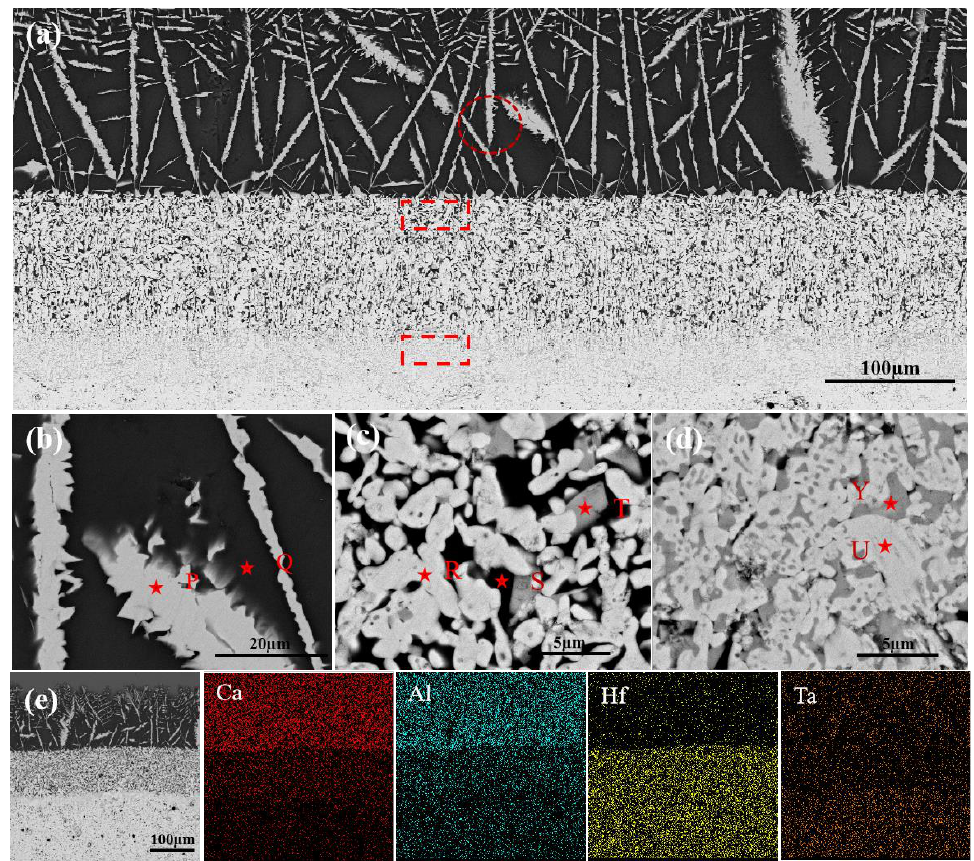
Figure 13. ( a ) A cross-sectional BSE image of Hf 6 Ta 2 O 17 ceramic after CMAS corrosion at 1400 °C for 16 h; ( b ) the high magnification BSE image corresponding to the dashed circle in ( a ); ( c ) the high magnification BSE image corresponding to the dashed rectangle in the reaction layer of ( a ); ( d ) the high magnification BSE image corresponding to the dashed rectangle in the dense layer of ( a ); ( e ) cross-sectional EDS mapping results of Hf 6 Ta 2 O 17 ceramic. Table 5. Chemical compositions of the marked regions in Figure 13.